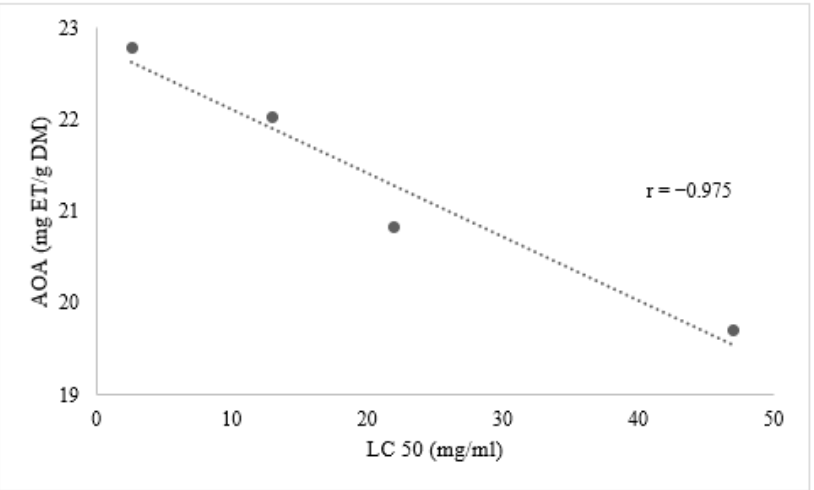
Figure 7. Relationship between antioxidant activity of methanolic leaf extracts and the larvicidal activity of aqueous leaf extracts of male plants of M .